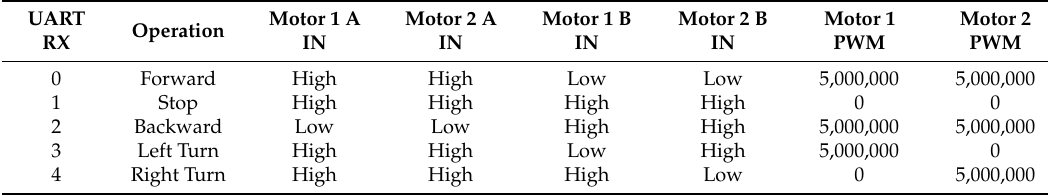
Table 4. Mobile robot control commands